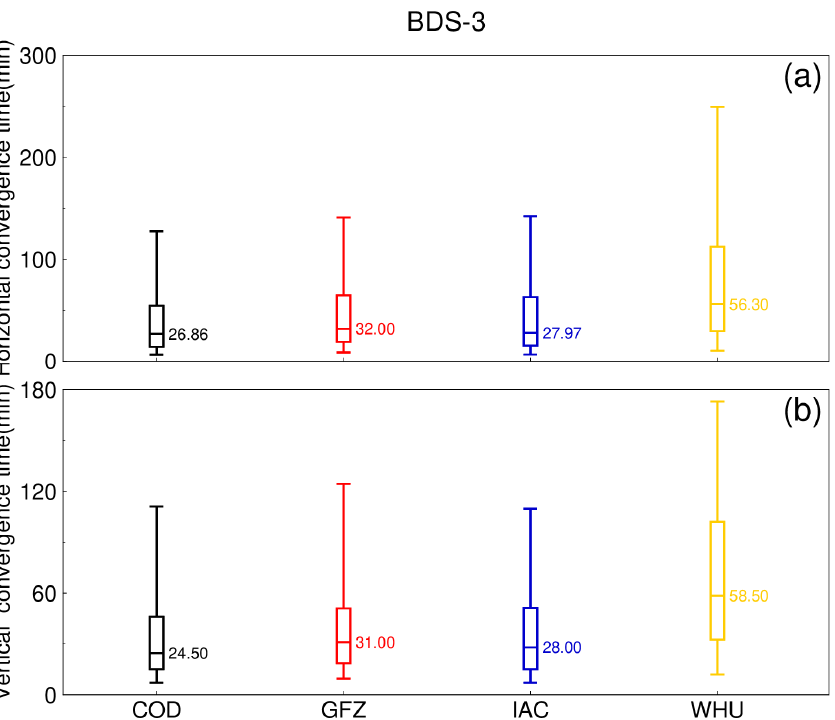
Figure 17. Distribution of the convergence time of the BDS-3 kinematic PPP solutions with five types of precise products for the 143 MGEX tracking stations in September 2022. ( a ) Horizontal component, ( b ) Vertical component.